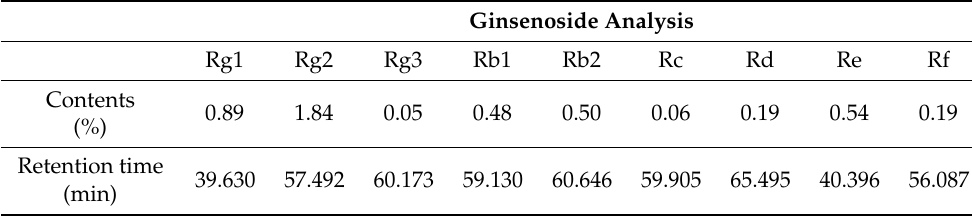
Figure 4. Identification and quantification of ginsenosides in RGE using HPLC. HPLC chromatograms of Rg1, Rg2, Re, Rf, Rb1, Rb2, Rc, Rd ( A ), and Rg3 ( B ). The peak in blue represents the standard and the red line represents the ginsenosides. The X -axis reports the retention time (RT) and the Y -axis reports the absorbance unit (AU). Table 2. Quantified ginsenoside contents in the RGE.